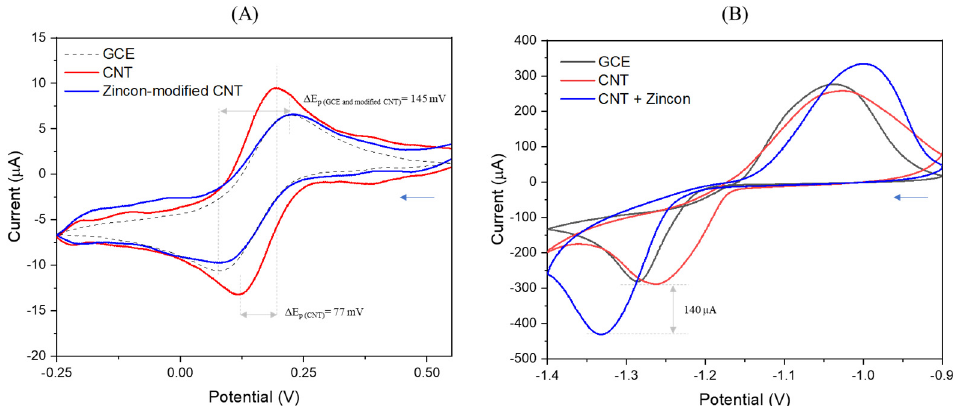
Figure 3. CVs for GCE, CNT and zincon–modified CNT in ( A ) 1 mM K 4 Fe(CN) 6 in a 0.1 M KCl and ( B ) tris HCl (pH 7.5) containing 0.5 mg · mL − 1 of zinc. The blue arrows mean the direction of the CV from + to − .